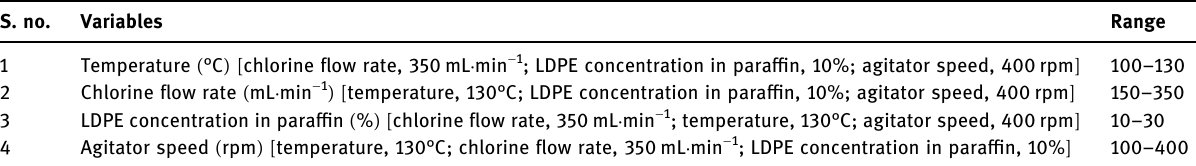
Table 2: Operating conditions adopted in co - chlorination experiments S. no.